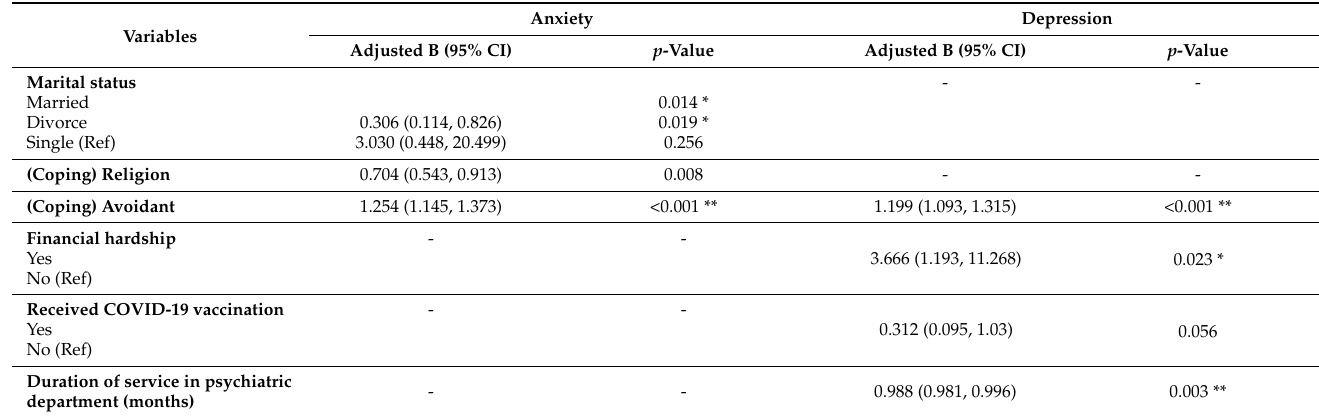
Table 4. Multiple logistic regression analysis of factors associated with anxiety and depression among psychiatric healthcare workers at University Malaya Medical Centre (n =